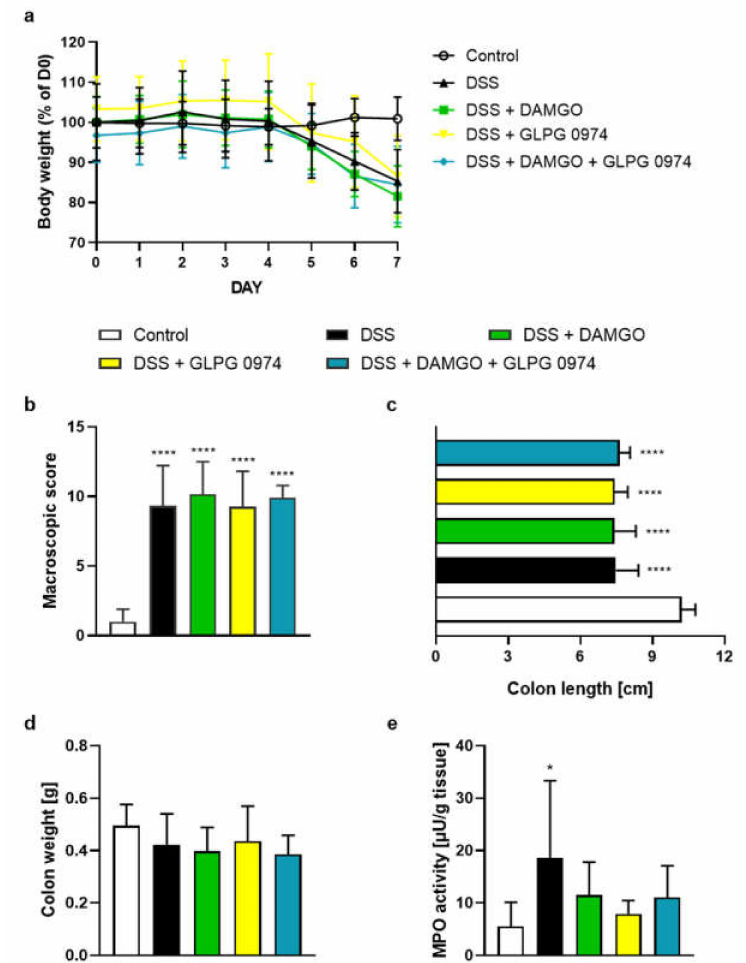
Figure 1. The i.p. administration of MOR agonist DAMGO (0.02 mg/kg BW) and FFAR2 antagonist GLPG 0974 (1 mg/kg BW) from day 3 to day 6, both once daily alleviate MPO activity, marker of DSS-induced colitis in mice. Figure shows data for body weight loss ( a ), macroscopic score ( b ), colon length ( c ), colon weight ( d ) and MPO activity ( e ). * p < 0.05, **** p < 0.0001, as compared to control mice. Data represent mean ± SEM of 5–10 mice per group. Abbreviations: DSS—dextran sulfate sodium, FFAR4—free fatty acid receptor type 4, i.p.—intraperitoneally, MOR— µ opioid receptor,